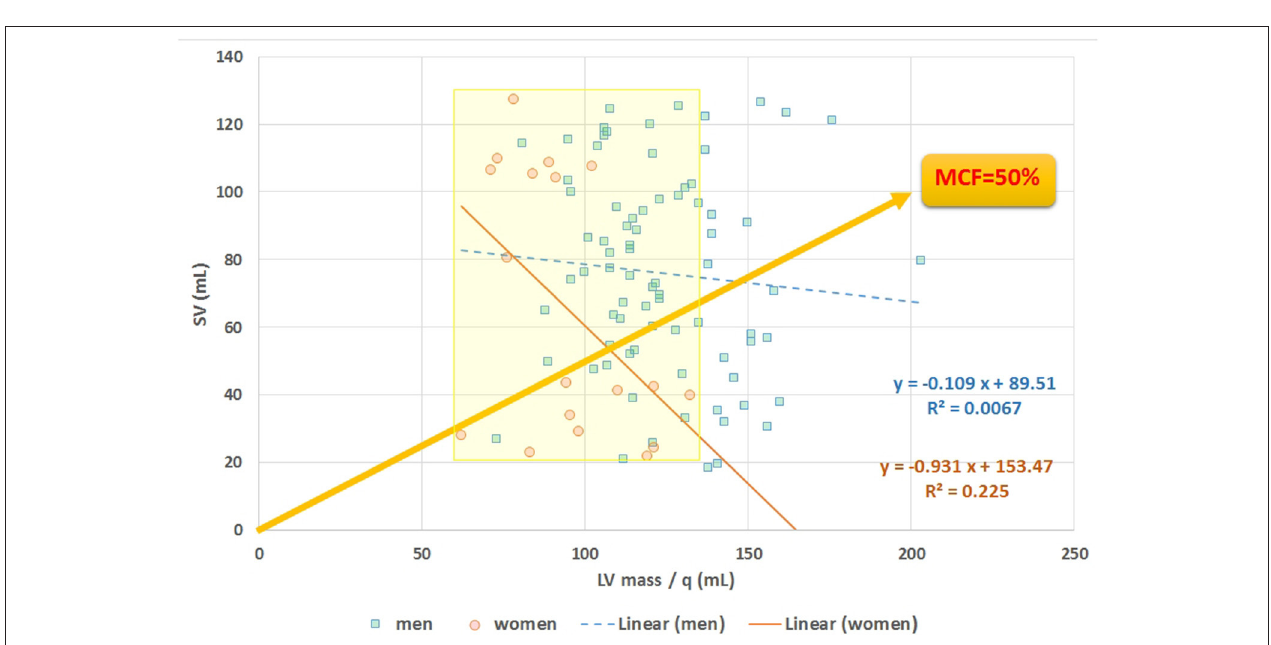
FIGURE 10 | Scatter plot of stroke volume (SV) vs. LVmass. The slope of any line refers to myocardial contraction fraction (MCF), with data points stratified for men and women, as exemplified by the yellow line referring to the case of MCF ( P < 0.0001) LVmass (see yellow marked